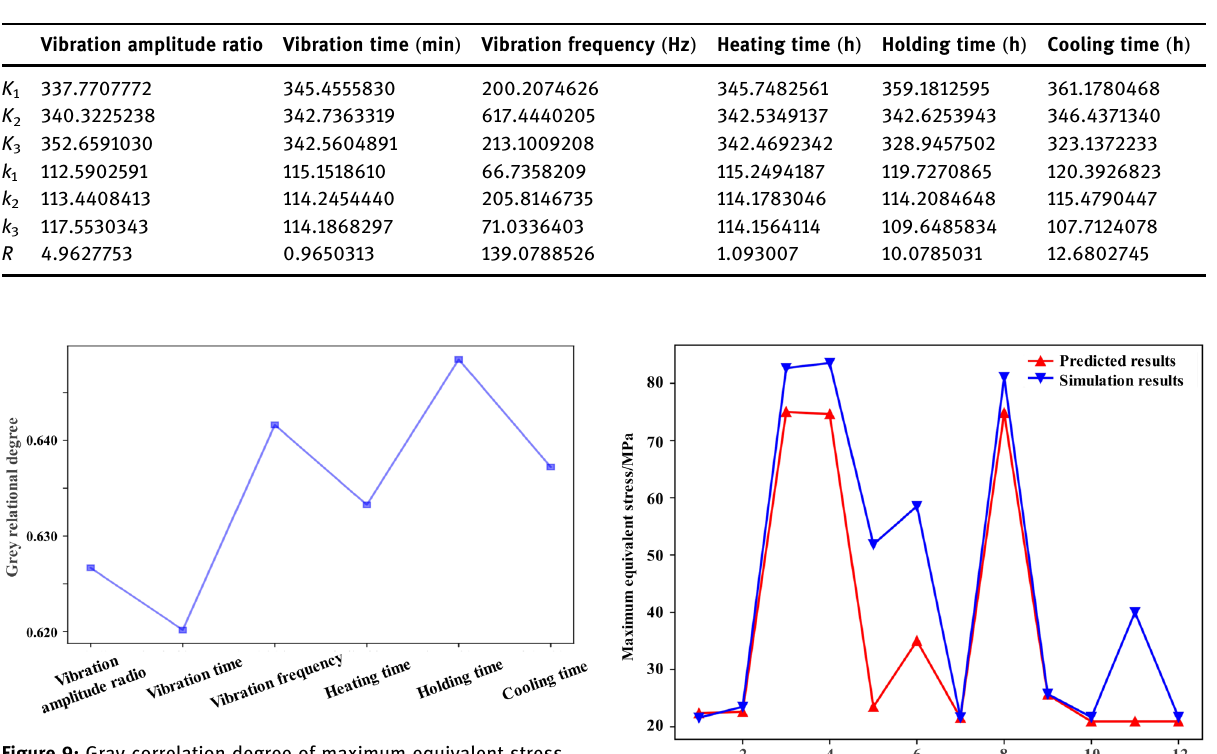
Table 5: Results of maximum equivalent stress range analysis